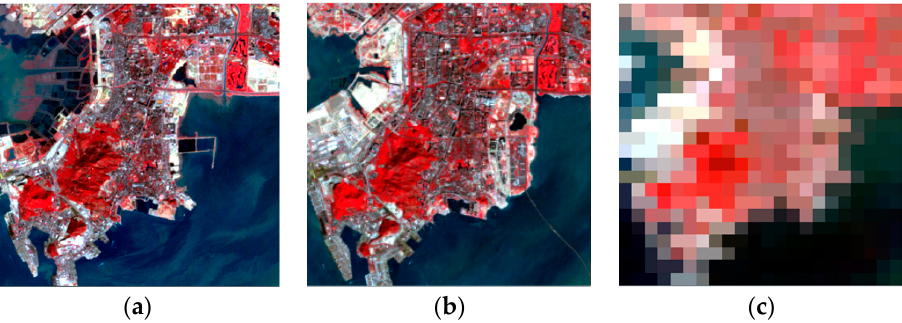
Figure 9. The original Landsat and Moderate Resolution Imaging Spectroradiometer (MODIS) images. ( a ) and ( b ) show the 30-m Landsat TM images (408 × 408 pixels) composed with band 4, 3, and 2 in 2001 and 2009, respectively. ( c ) shows the 500-m MODIS image (24 × 24 pixels) composed with band 2, 4, and 3 in 2009.